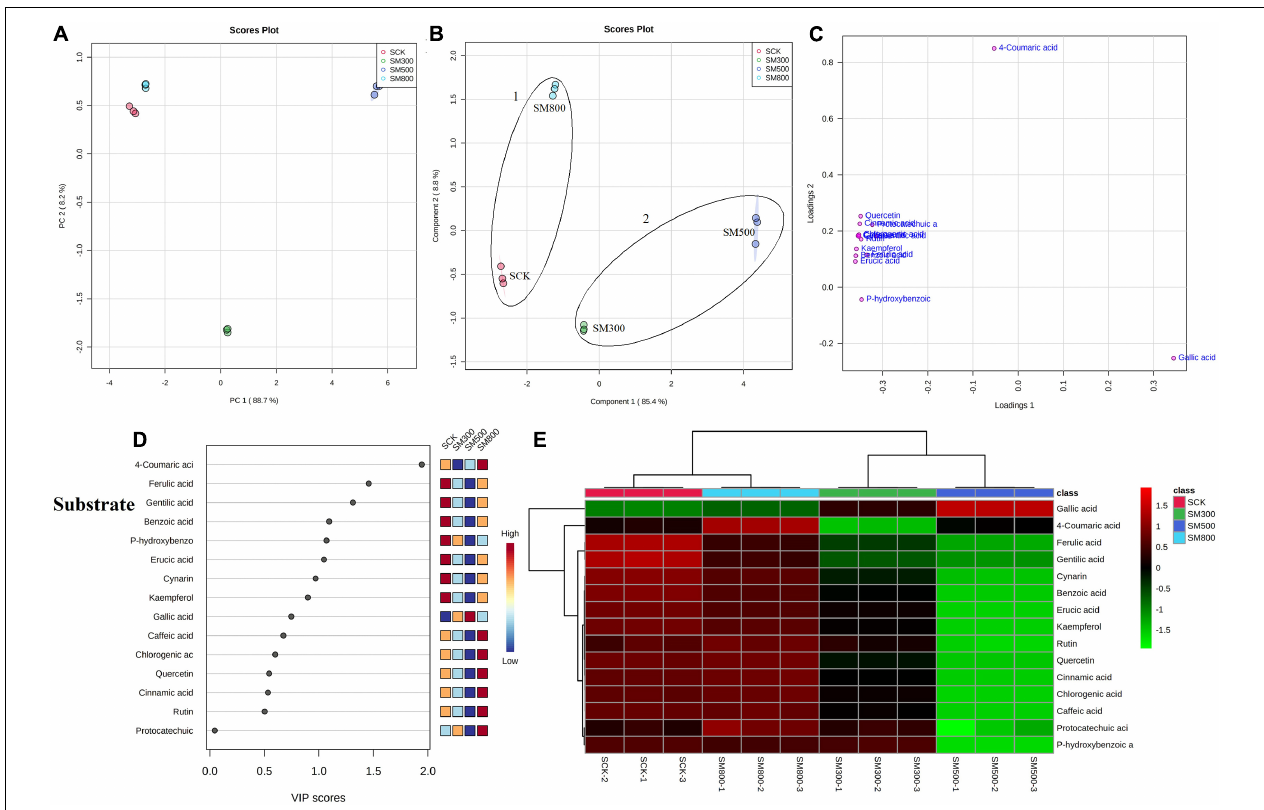
FIGURE 5 | Statistical analyses of bioactive metabolites in substrate-grown Chinese chive treated with methyl jasmonate (MeJA). (A) An unsupervised principal component analysis (PCA) score plot of phenolic metabolites. (B) A partial least squares discriminant analysis (PLS-DA) score plot of phenolic metabolites. (C) PLS-DA score plots loaded with different phenolic metabolites. (D) VIP scores of phenolic metabolites in PLS-DA. The scores from low to high determine the importance of variables. The colored boxes on the right show the relative concentration of each metabolite from low (blue) to high (red). (E) Heat map of phenolic concentrations. The colored areas correspond to the concentrations of different amino acids from low (green) to high (red) in groups treated with different concentrations of MeJA. Each row represents a phenolic, and each column represents a